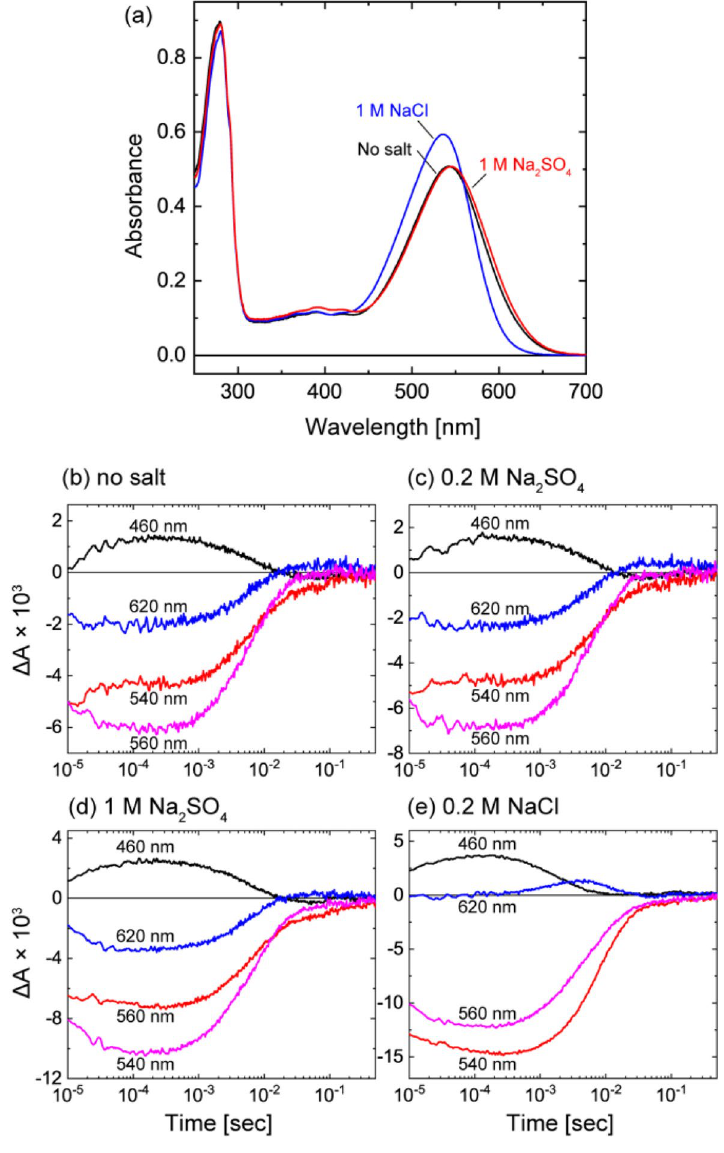
Figure 7. Absorption spectra ( a ) and photoreactions ( b – e ) of T183D SyHR. The basal buffer was 50 mM citric acid, pH 6.0. ( a ) The purified protein was used. All buffer solutions contained 0.05% DDM. ( b – d ) The sample preparations and the measuring conditions were the same as those of Fig.